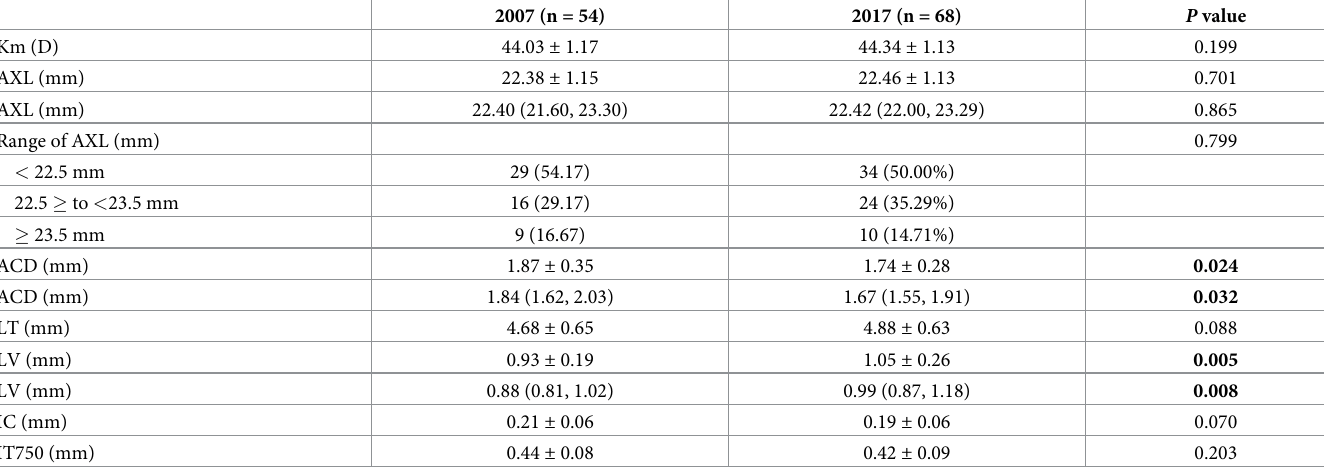
Table 4. Biometric parameters of acute primary angle closure in 2007 and 2017.